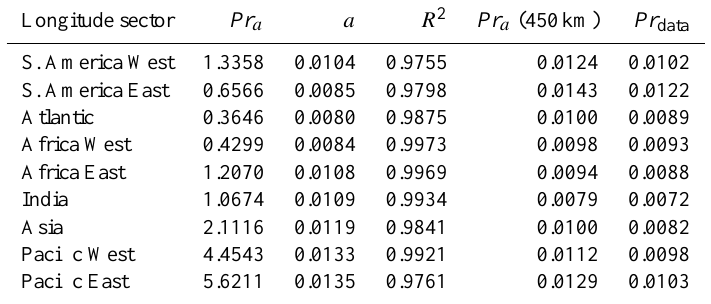
Table 1. Results from the least square fit of the exponential trend line Pr a (h) = Pr a exp ( − ah) to data of Fig. 7b. A trend line is most reliable when its R 2 value (0 ≤ R 2 ≤ 1) in the fourth column is at or near 1. The column Pr data lists the values of the bin [400–500km) of Fig. 7b.